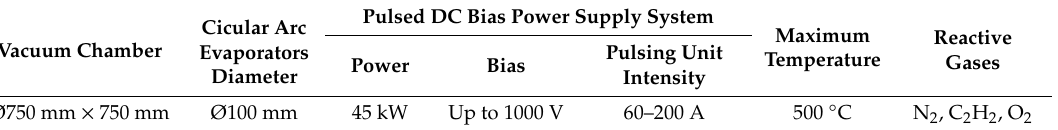
Table 1. Technical data of MIDAS 775